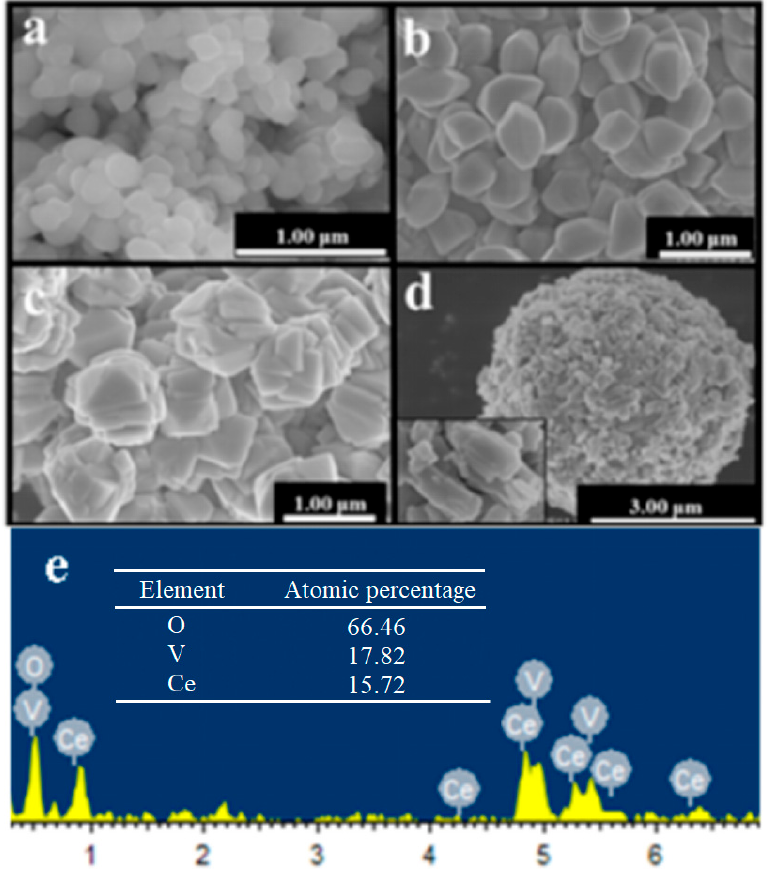
Figure 2. SEM of CeVO 4 -V 2 O 3 prepared with EG addition amounts of 0 ( a ), 5 ( b ), 10 ( c ) and 15 mL ( d ) and EDS of CeVO 4 -V 2 O 3 prepared with EG addition amounts of 15 mL ( e ).